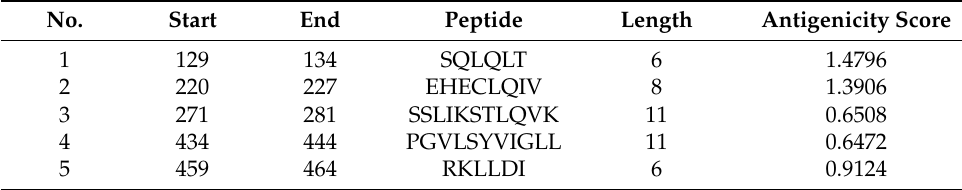
Table 1. Predicted B-cell epitopes based on antigenicity